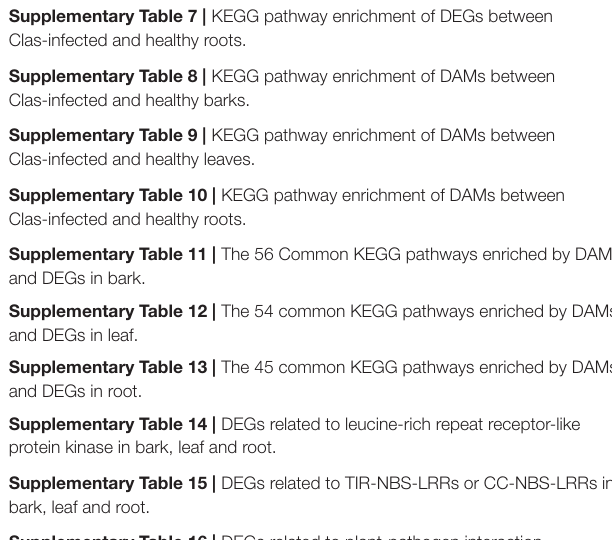
Supplementary Table 16 | DEGs related to plant-pathogen interaction. Supplementary Table 17 | DEGs related to plant hormone signal transduction. Supplementary Table 18 | DEGs related to starch, sucrose and galactose metabolism. Supplementary Table 19 | DEGs related to carbon fixation and photosynthesis-antenna proteins. Supplementary Table 20 | DEGs related to carotenoid biosynthesis and nitrogen